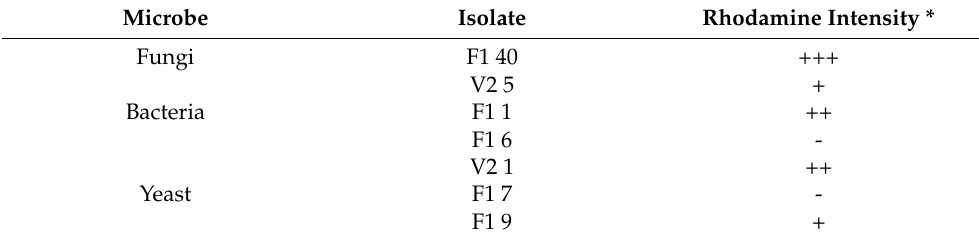
Table 5. Top crude-oil-degrading genera in the 8 sites in southwestern Trinidad.